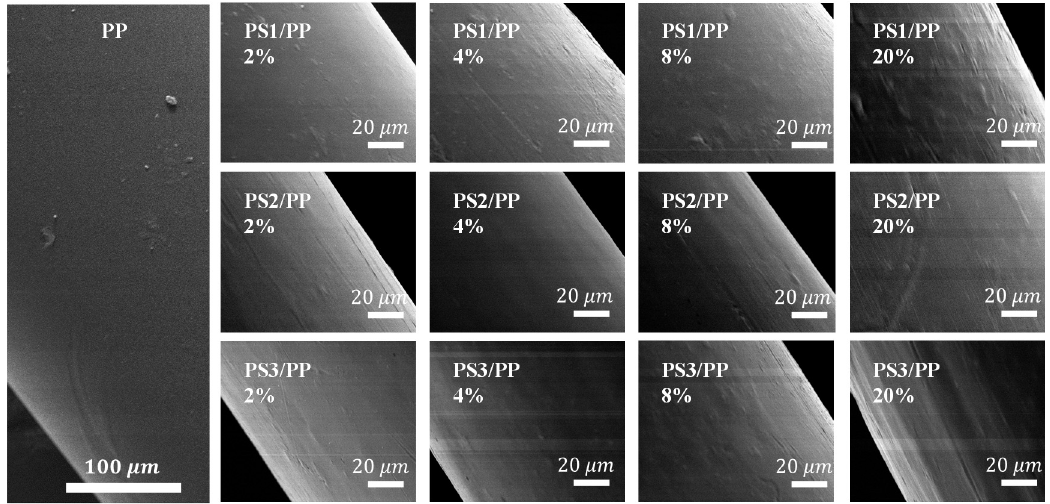
Figure 3. Surface micrographs of PS/PP fibers produced with different viscosity ratios and blend ratios.